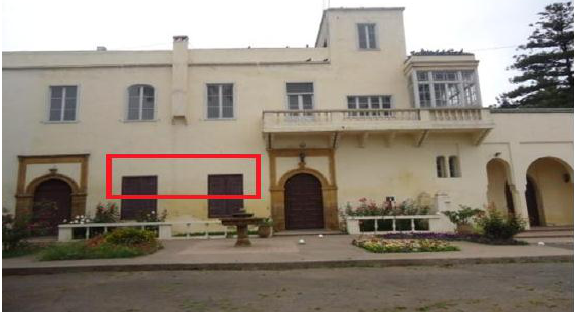
Figure 1. Former residence of General Lyautey. The red frame shows a surface sample where two elements are located in the same plane (wall and window